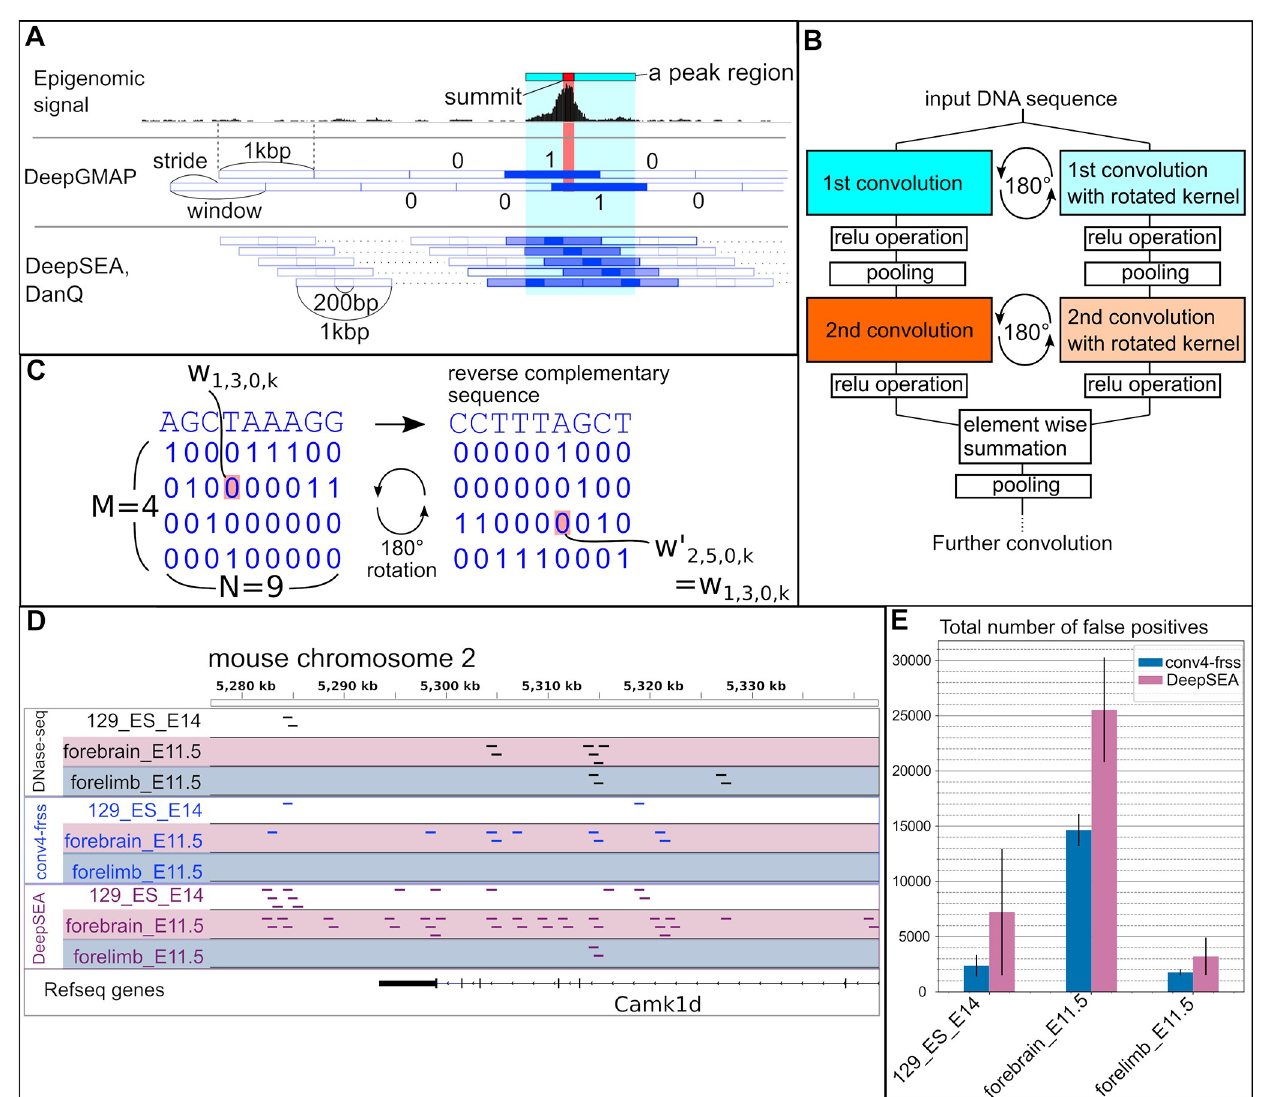
Fig 1. The Forward- and Reverse-Sequence Scan (FRSS) layers and data structures. ( A ) Schematic representation of how to assign an epigenomic signal into a binary vector. A peak region (light blue bar) and the summit of a peak (red rectangle) are determined from epigenomic data and assigned as "1" to overlapping genomic regions (blue-filled rectangle), otherwise "0" (blue, empty rectangle). DeepGMAP, this study; DeepSEA, DanQ, previous studies. ( B ) The architecture of the FRSS layers. An input sequence is scanned by the first convolution kernels, and the kernels are rotated in parallel. After implementing the relu operation, pooling, and the second convolution, the two parallel outputs are combined through summation. ( C ) Illustration of the 180-degree rotation of kernels. Each variable in an M × N kernel is written as w m , n , h , k ([ m ] = {0, ... , M − 1};[ n ] = {0, ... , N − 1};[ h ]= {0, ... , H − 1};[ k ] = {0, ... , K − 1}; H and K are the numbers of the channels and kernels, respectively). w 0 m 0 , n 0 , h , k is a variable after the 180-degree rotation, and equal to w ( M − 1 − m ),( N − 1 − n ), h , k (also see Methods). In this example, a 9 × 4 kernel is trained to detect a sequence, AGCTAAAG (left). The geometric rotation of the kernel (right) results in the reverse complement of the original sequence. ( D ) A visual comparison between DNase-seq peaks and predictions of the conv4-FRSS and DeepSEA models. Black boxes indicate 1 kb-windows that overlap with peaks. Blue and purple boxes indicate peak regions predicted by the indicated models. Note that DeepSEA predictions contains many false positives. ( E ) The total number of false positives predicted by the DeepSEA model (purple) and the conv4-FRSS model (blue). The averages were calculated from predictions by three independently trained models. benchmark is composed of 16747 mini-batches (each mini-batch contains 100 data). For eval- uation, we used the entire chromosome 2 sequence, which was excluded from training data- sets, and calculated the prediction accuracy of models using two scores, namely the area under the receiver-operation curve (AUROC) and the area under the precision-recall curve